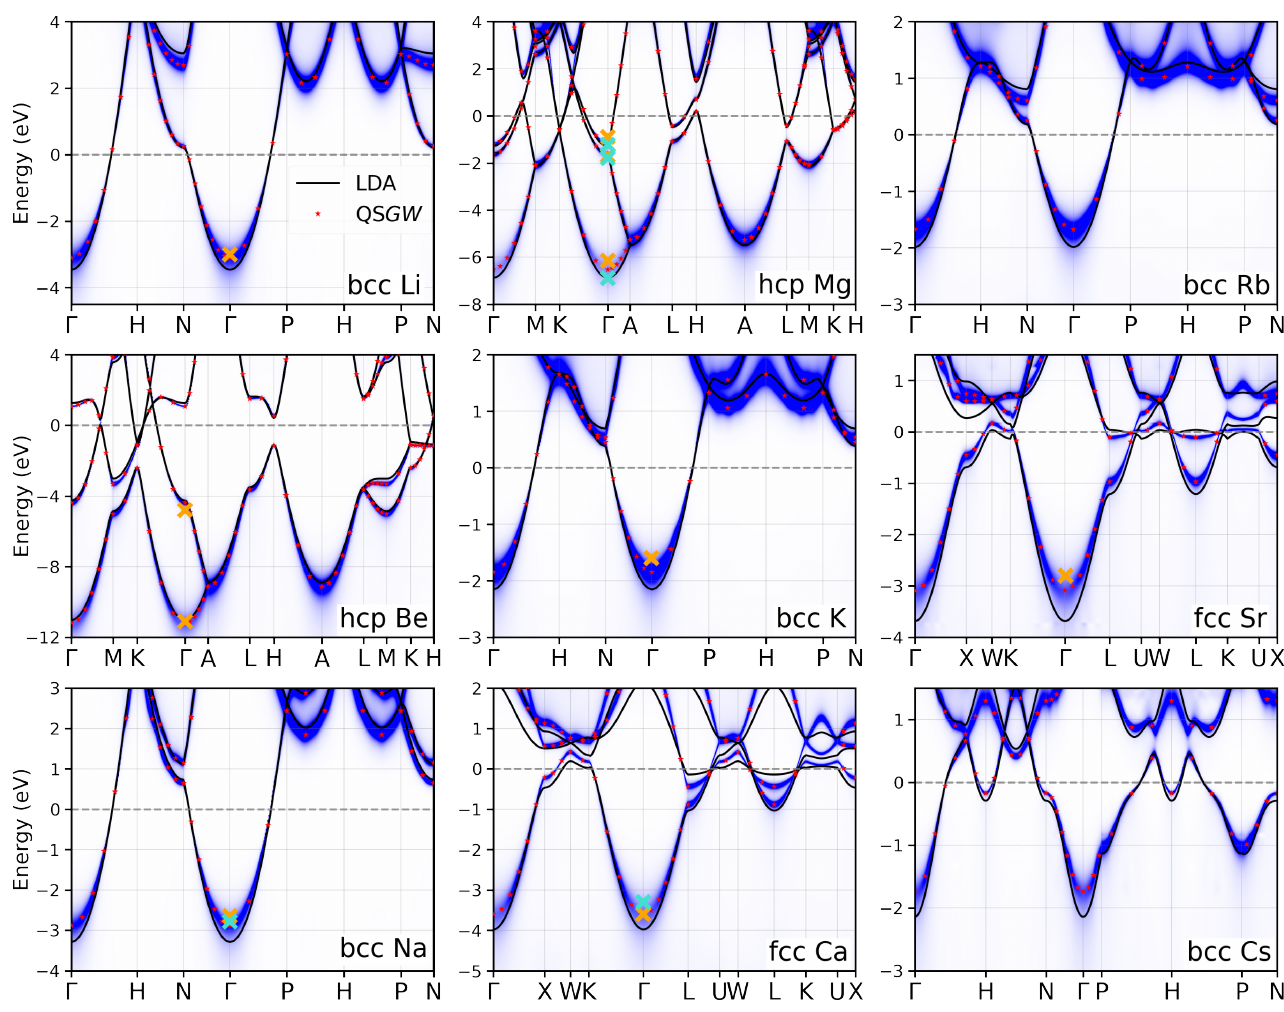
Figure 1. Electronic band structures of the simple metals calculated with LDA (solid black line) and QS GW (red stars). The Wannier-interpolated QS GW spectral functions are shown as intensity plots in blue. The band broadening scales with the inverse excitation lifetime and vanishes at the Fermi energy (0 eV). The orange crosses mark experimental binding energies. If two experimental values are available (see Table 3), the turquoise cross shows the more recent